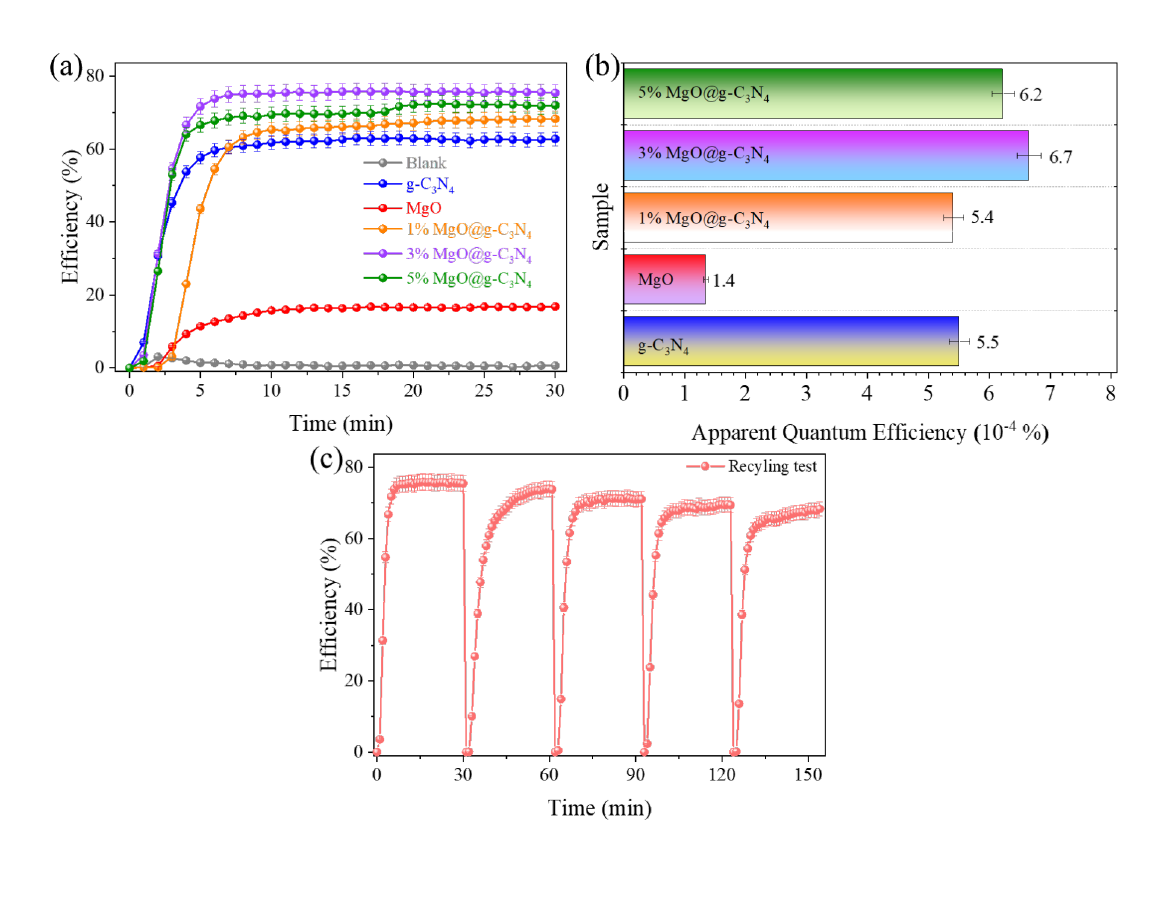
Figure 2: (a) Photocatalytic NO degradation efficiency, (b) apparent quantum efficiency of the materials, and (c) photocatalytic recycling test of 3% MgO@g-C 3 N 4